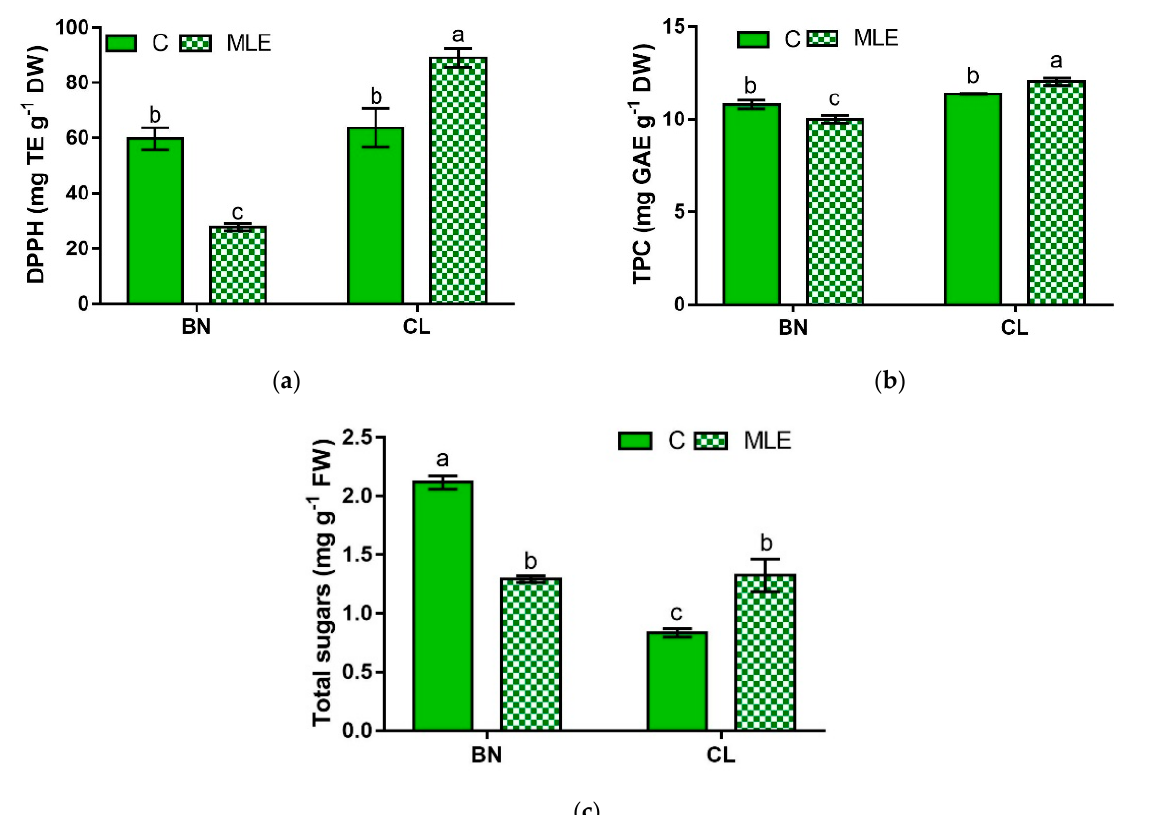
Figure 4. Effect of interaction of antioxidant activity, DPPH ( a ), total phenol content, TPC ( b ), and total sugar content ( c ), from leaves of BN and CL treated with distilled water (C) and MLE. Values are the means ± SE ( n = 3). Different letters indicate the differences among treatments.